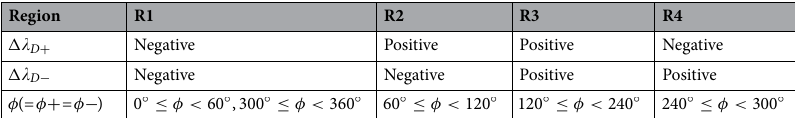
Table 1. Definition of four regions (R1–R4) and corresponding ranges of φ (= φ + = φ − ).